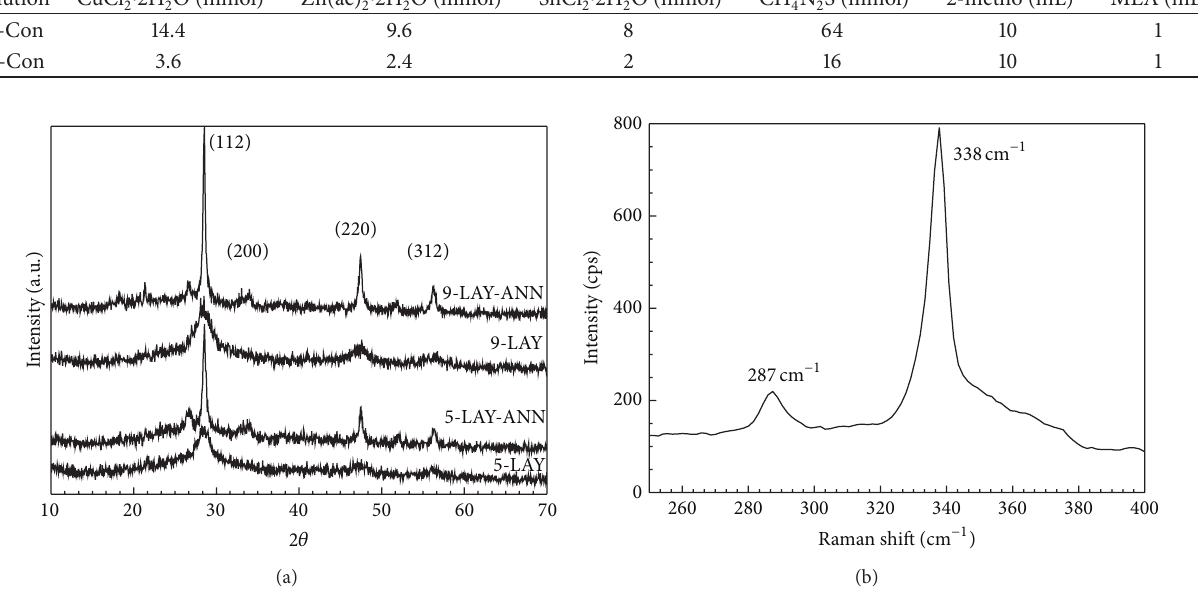
Figure 1: (a) XRD patterns of the CZTS films. (b) Raman spectrum of 9-LAY-ANN CZTS thin